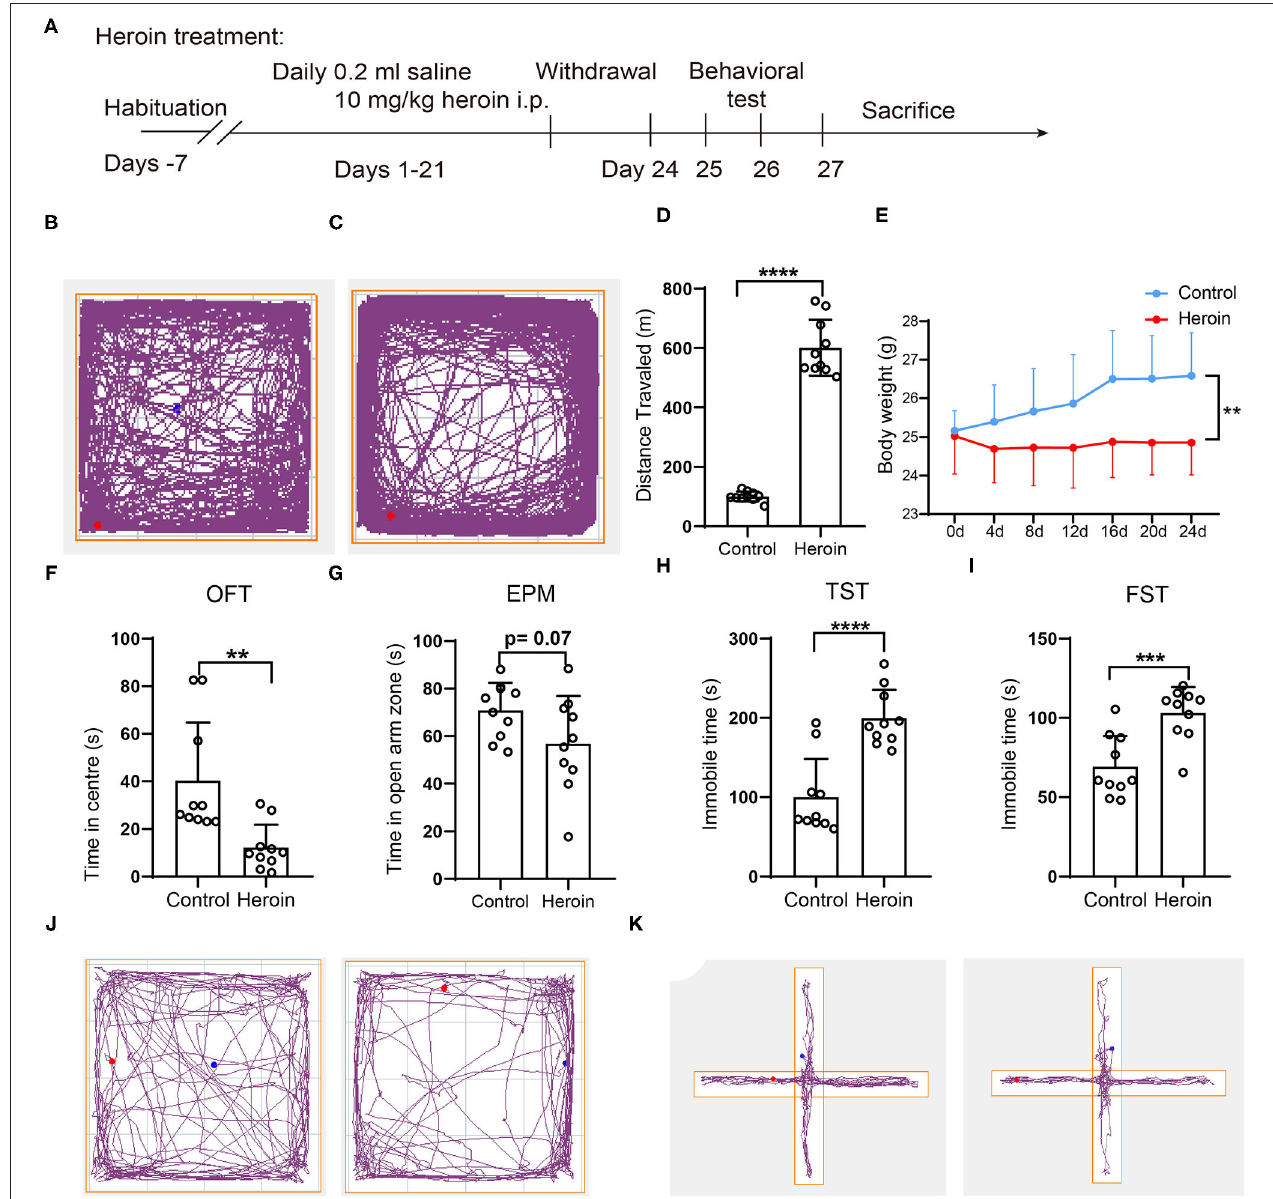
FIGURE 1 | Heroin-induced mouse behavior sensitization, neurobehavioral deficits, and body weight loss in C57/BL mice. (A) experimental design: C57/BL mice were administered an intraperitoneal (i.p.) injection of 10 mg/kg heroin for 21 days. After a 48-h withdrawal period, fresh fecal samples were collected for 16s rRNA sequencing, and cecal tissues were collected after sacrifice. (B–D) A 10 mg/kg heroin administration induced behavior sensitization. Track plots showing the position of the animal for 60-min tests where treatment with control (B) and heroin (C) ( n = 10); (D) Bar graphs show total distance traveled of the open field during the test. (E) Heroin- administrated mice showed reduced body weight compared to controls. (F–K) heroin-administrated mice exhibit anxiety and depression-like behavioral deficits: (F) time spent in the central area of the open field during the test; (G) time spent in open arms of the elevated plus maze; (H) Immobility time during the tail suspension test; (I) Immobility time in the forced swim test; (J) Track plots showing the position of the animal for 5-min tests in OFT where treatment with saline (left) and heroin (right); (K) Track plots showing the position of the animal for 5-min tests in EMP where treatment with saline (left) and heroin (right) ( n = 10). The student’s t -test was used to determine whether differences existed between the two groups, ** p < 0.01; *** p < 0.001; **** p < 0.0001. All data are expressed as the mean ± SD.